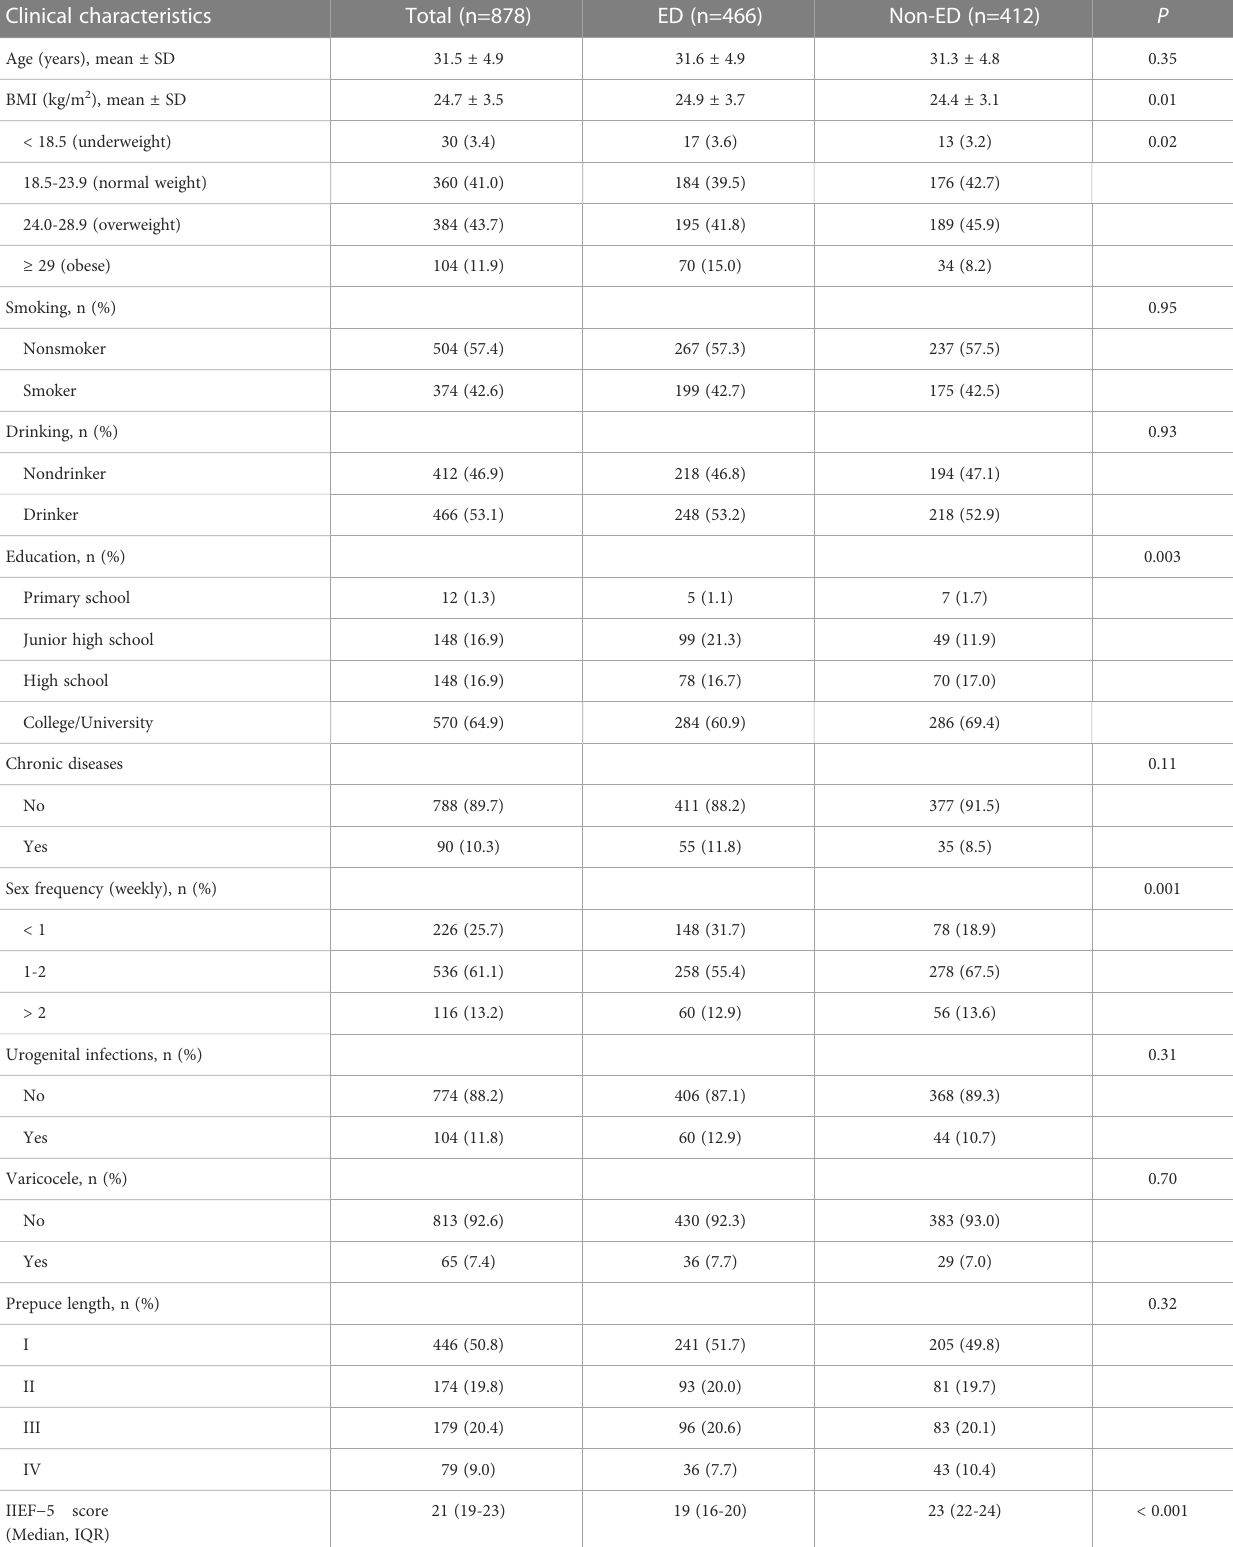
TABLE 1 Characteristics and descriptive statistics of the whole cohort. Clinical